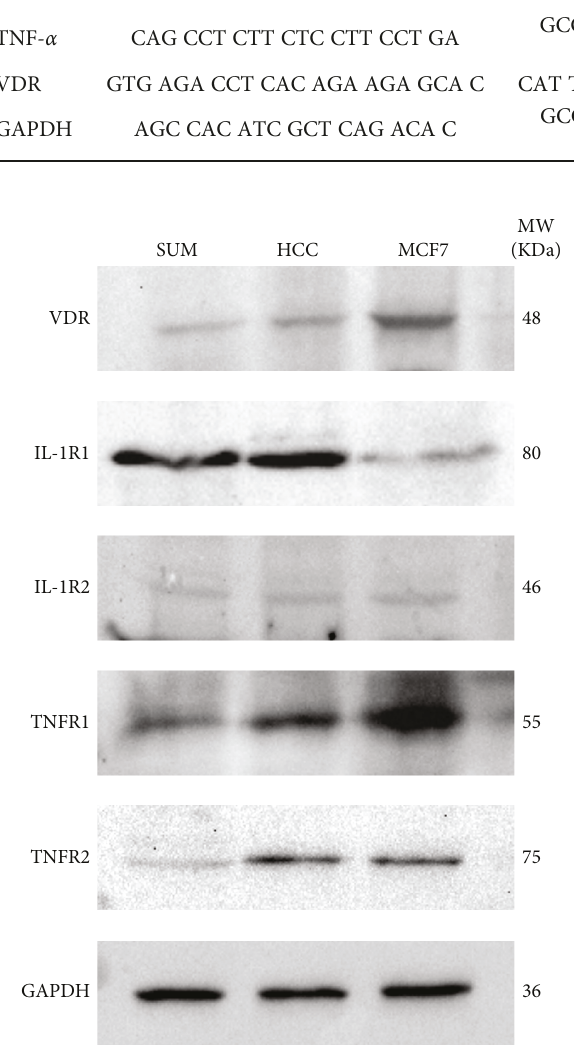
Figure 1: Expression pattern of VD, IL-1 β , and TNF- α receptors in TNBC established cell lines. Cell lysates from untreated SUM- 229PE (SUM), HCC1806 (HCC), or MCF7 were separated by SDS-PAGE. Thereafter, proteins were transferred to nitrocellulose membranes and incubated in the presence of speci fi c antibodies. GAPDH was used as loading control. A representative image of a Western blot from two independent experiments is shown.